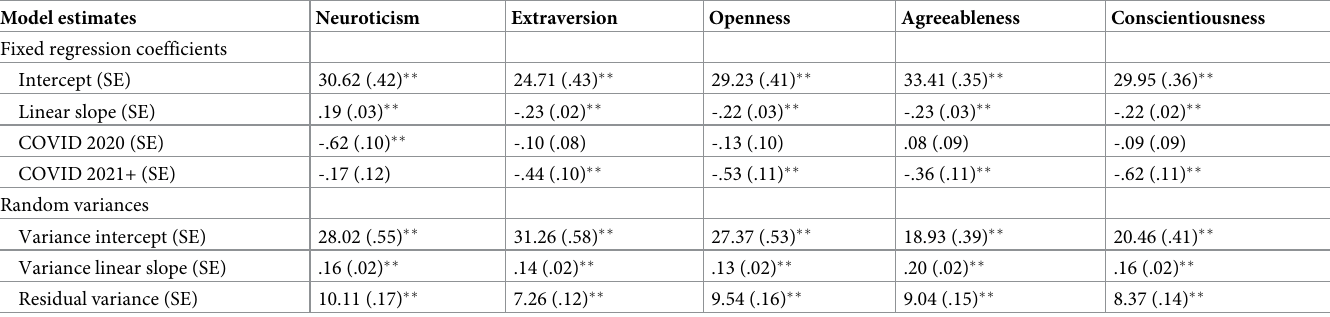
Table 2. Multilevel modeling of personality change from before to during the